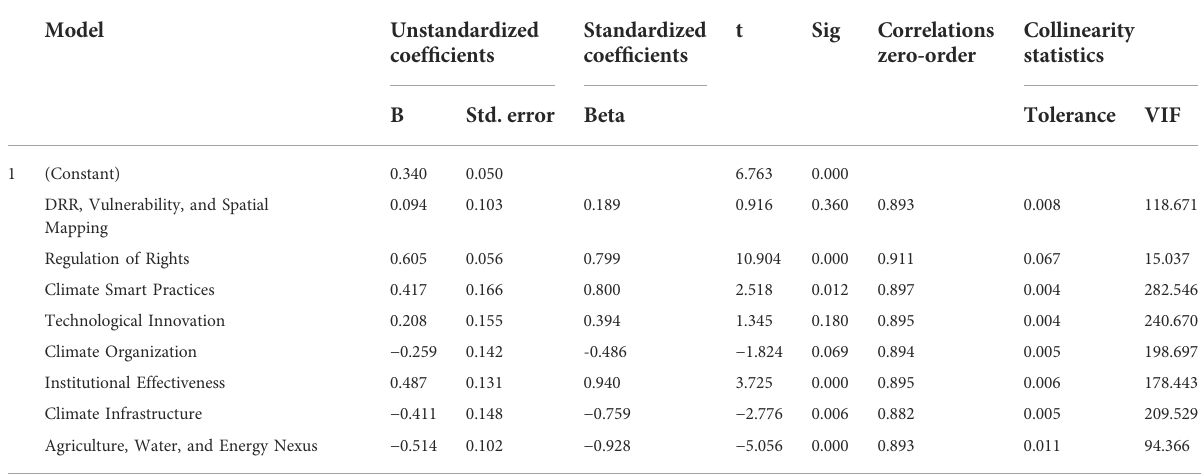
TABLE 6 Criteria wise summary of regression coef fi cients for GC-1 in the energy sector.